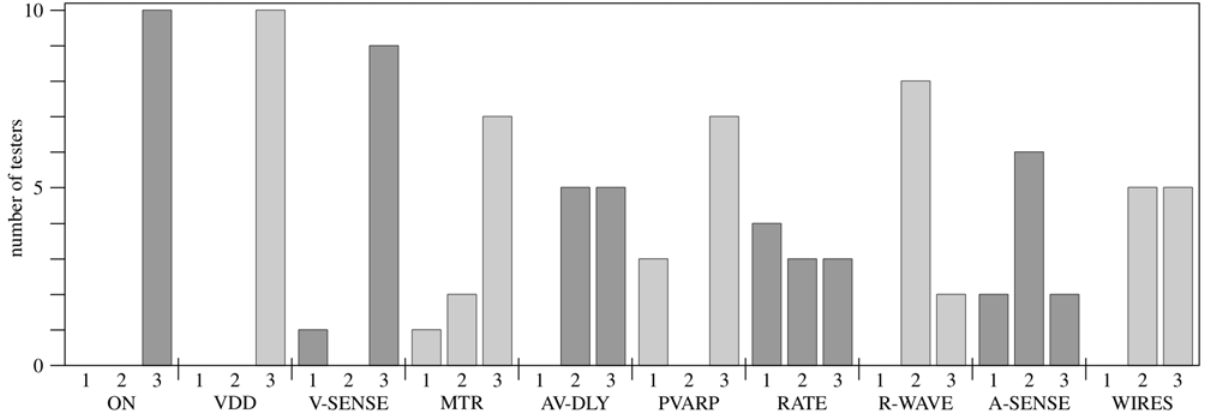
Fig 5. Simulator testing. Ten pediatric cardiologists were asked to establish AVT pacing. Ten working steps were assessed: ON, switching on the pacemaker; VDD, choosing the VDD mode; V-SENSE, adjusting ventricular sensing for maximal insensitivity; MTR, selecting the maximal tracking rate at a value 10 – 20 bpm above the patient´s heart rate; AV-DLY, setting the AV delay to the maximum allowed value; PVARP, adjusting the post ventricular atrial refractory period to 100 ms; RATE, selecting a basic stimulation rate clearly below the patient´s heart rate; R-WAVE, measuring the ventricular input signal; A-SENSE, selecting an atrial sensitivity 50% of the ventricular input signal; WIRES, connecting the pacing wires of the pacemaker. Three points indicate perfect, 2 points suboptimal performance, and 1 point a mistake that impairs safe or effective AVT